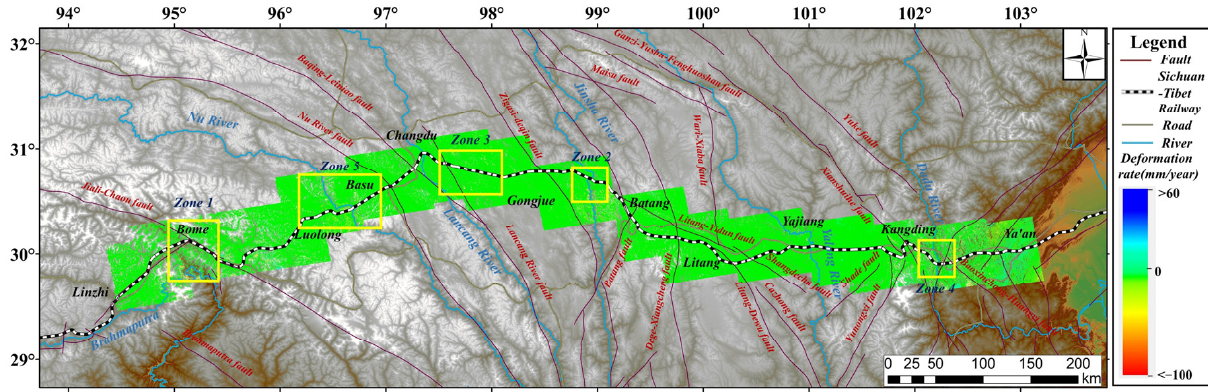
Figure 5. Annual LOS deformation rate maps calculated by using synthetic aperture radar (SAR) data. The yellow rectangle represents a dense area of large-scale landslides.